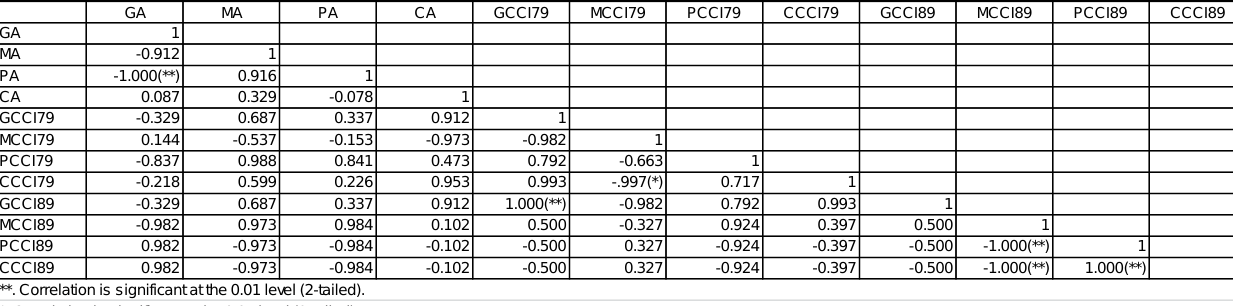
**. Correlation is significant at the 0.01 level (2-tailed). *. Correlation is significant at the 0.05 level (2-tailed). Figure 5. Pearson correlation test results for the second year for total anthocyanin from the grapes vs. the total chlorophyll content in the leaves (G, M, P, C correspond with the four studied varieties Gelu, Moldova, Purpuriu, and Coarna neagra , respectively, GA, MA, PA, and CA are the anthocyanin concentrations, GCCl79, MCCl79, PCCl79, and CCCl79 are the chlorophyll concentrations for the four varieties corresponding with the BBCH phase 79, whereas GCCl89, MCCl89, PCCl89, and CCCl89 are the chlorophyll concentrations for the corresponding varieties in the BBCH — 89 phase). For the Moldova variety, there were positive correlations between the anthocyanins and the physiological parameters, but only in the second year when the anthocyanin con- tent was maximum. For both years there were positive correlations between the total chlo- rophyll content and the other physiological indicators, especially during BBCH 65. Even if the anthocyanin content was not so high in the Purpuriu variety compared to the others, it was positively correlated with all measured physiological parameters during both years; at the same time, the chlorophyll content had a positive correlation with leaf temperature, PAR, stomatal CO 2 , and WUE in all the development stages.